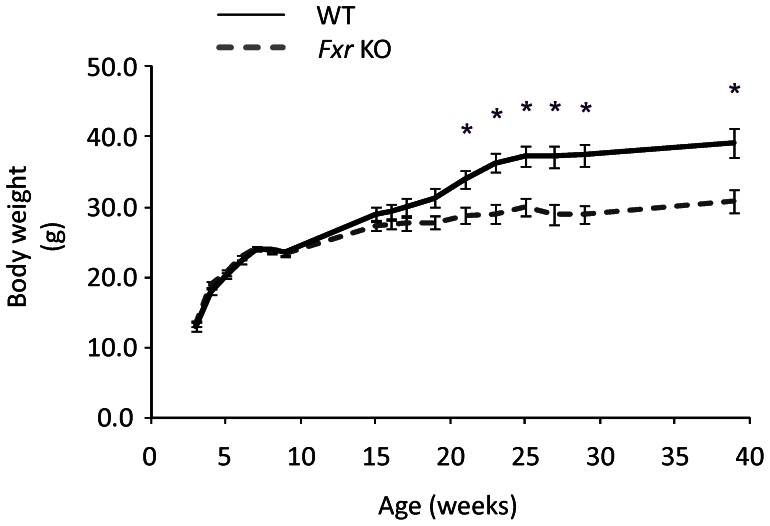
Body weight development.Body weight development over 39 weeks in WT (n = 8, black solid line) and Fxr KO mice (n = 8, grey dashed line). Statistical analysis was done by a repeated Student' T-test. * p<0.05 Fxr KO vs. WT mice.